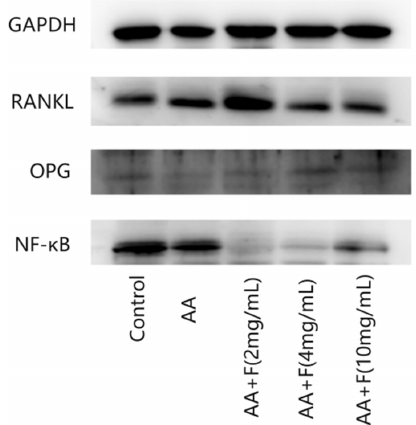
Figure 4. Expression of OPG, RANKL, NF ‐κ B protein detected by Western blot.